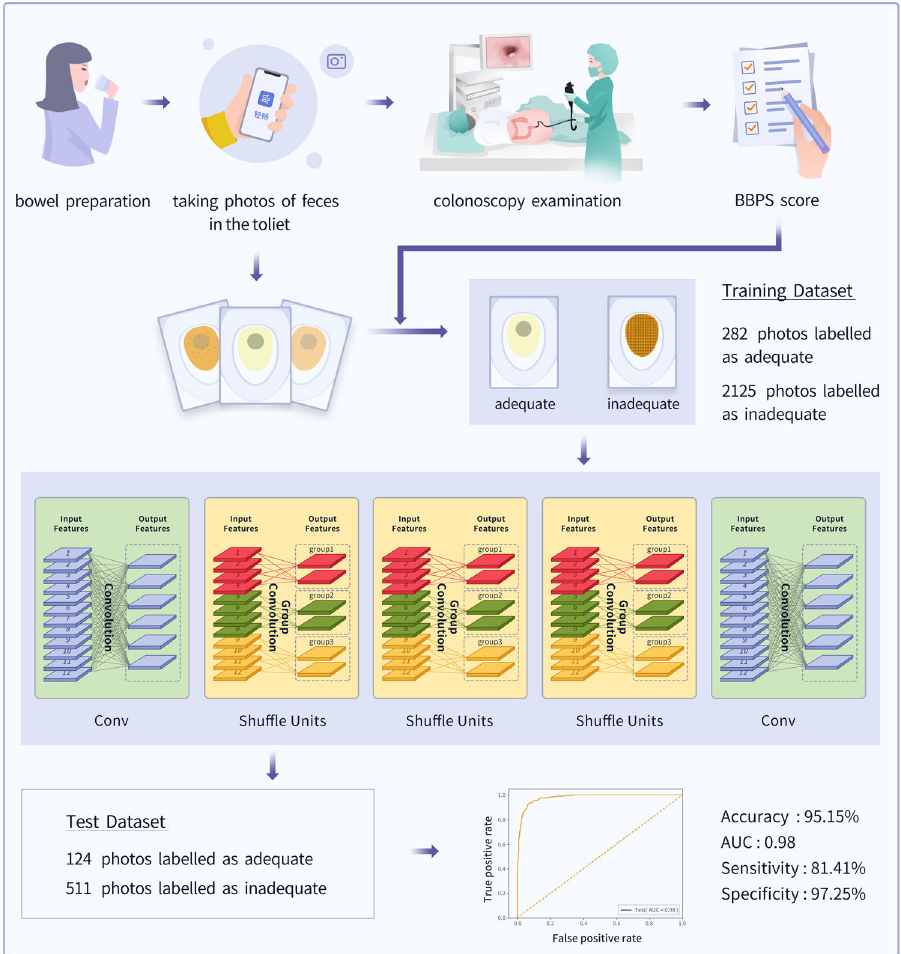
Fig. 3 Entire process of creating the arti fi cial intelligence-based bowel preparation prediction system. AUC area under the receiver operating characteristics curve, Conv